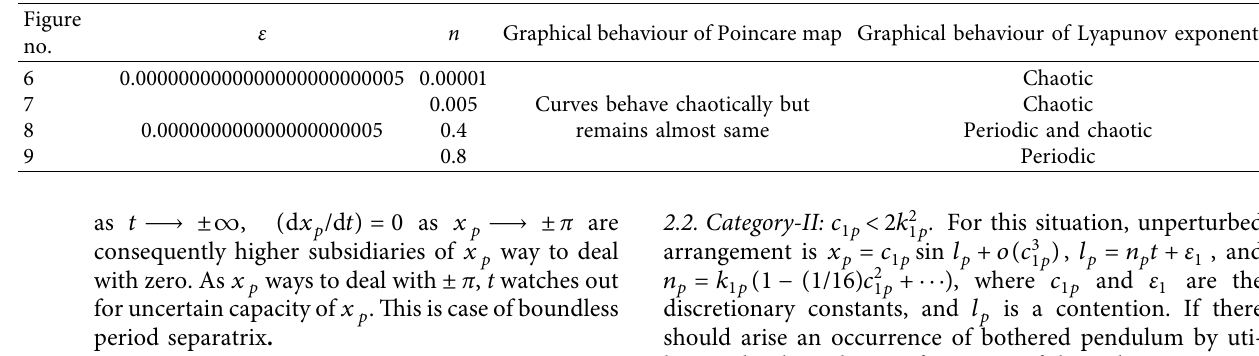
� 3 . 36 E + 09 ,D � − 4 E + 08 , B � 1596 . 387 , C � − 103631 , E � 200 . 1022 , and e � ∗ ∗ ∗ ∗ ∗ � 3 . 36 E + 09 ,B � 1596 . 387 , C � − 103631 ,D � − 4 E + 08 ,E ∗ ∗ ∗ ∗ ∗